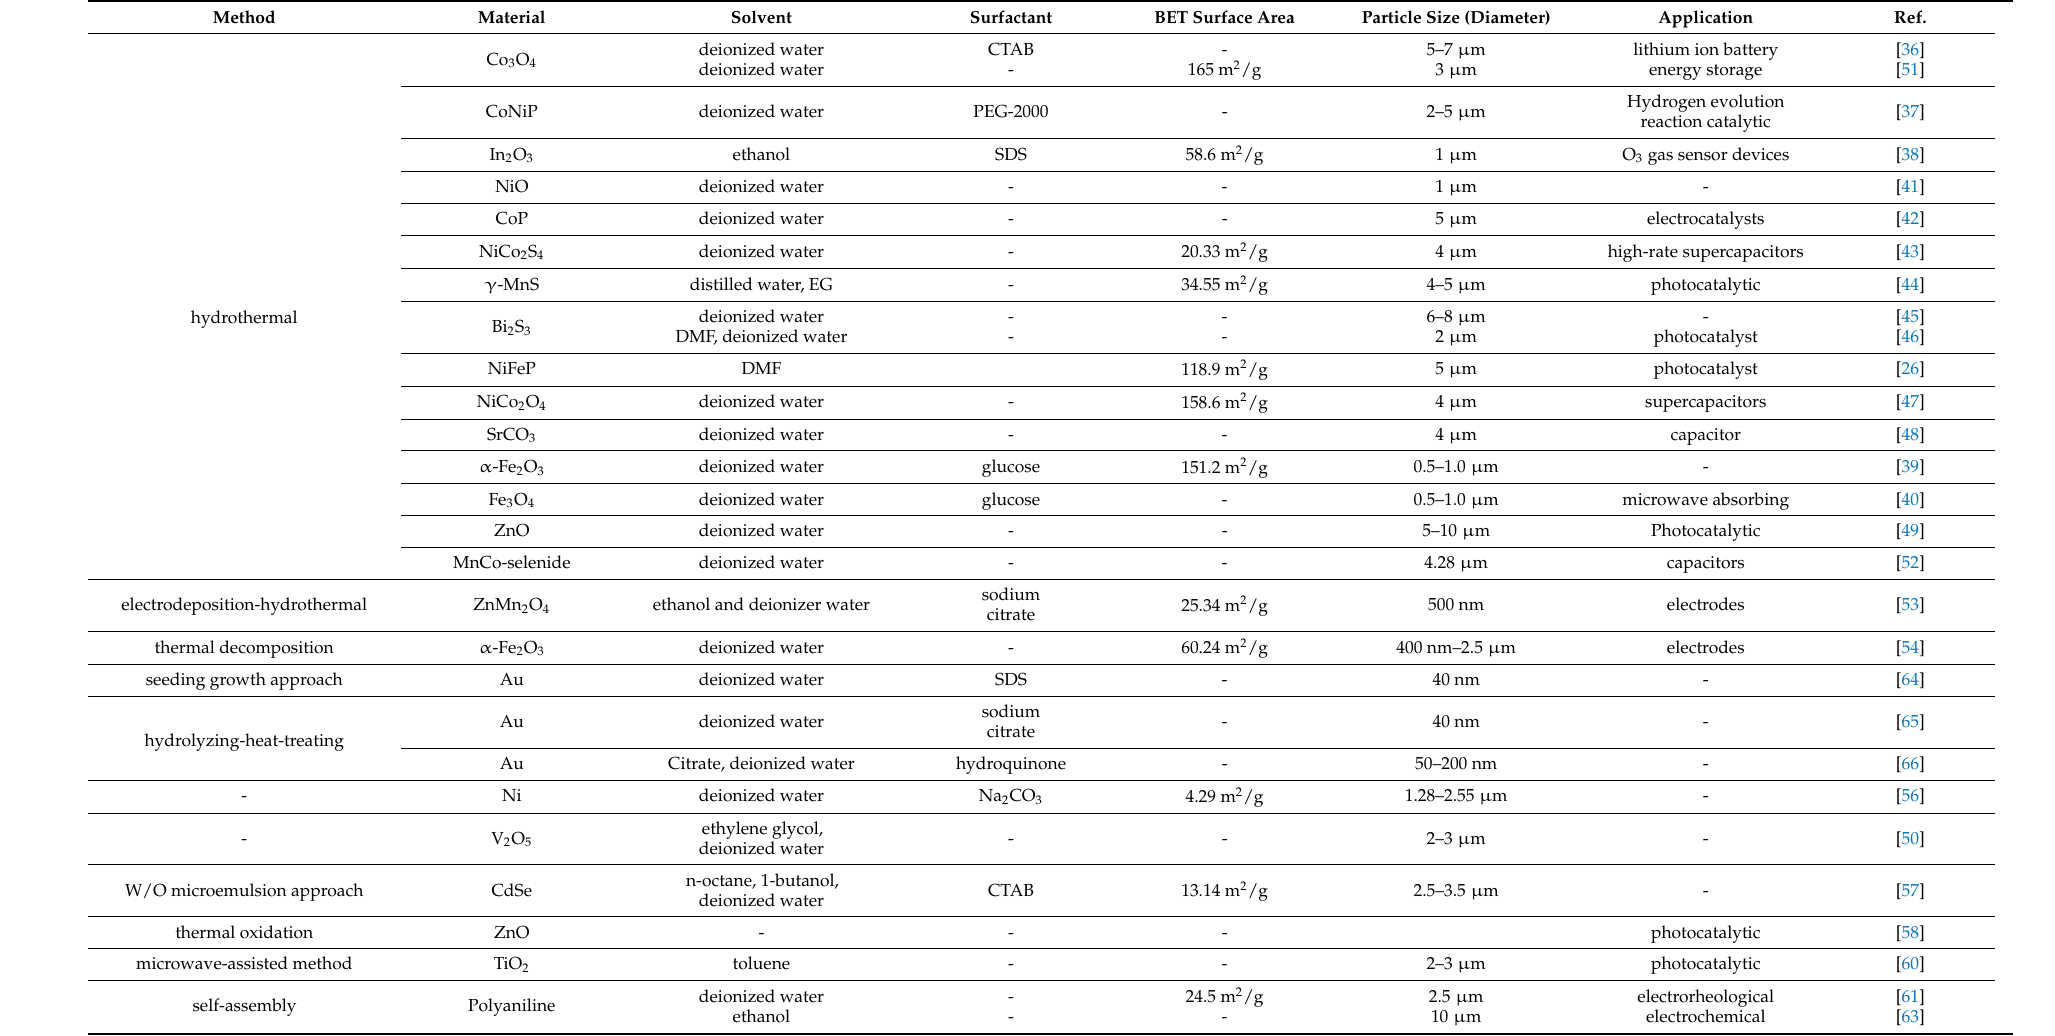
Table 1. Synthetic method and properties of solid urchin-like